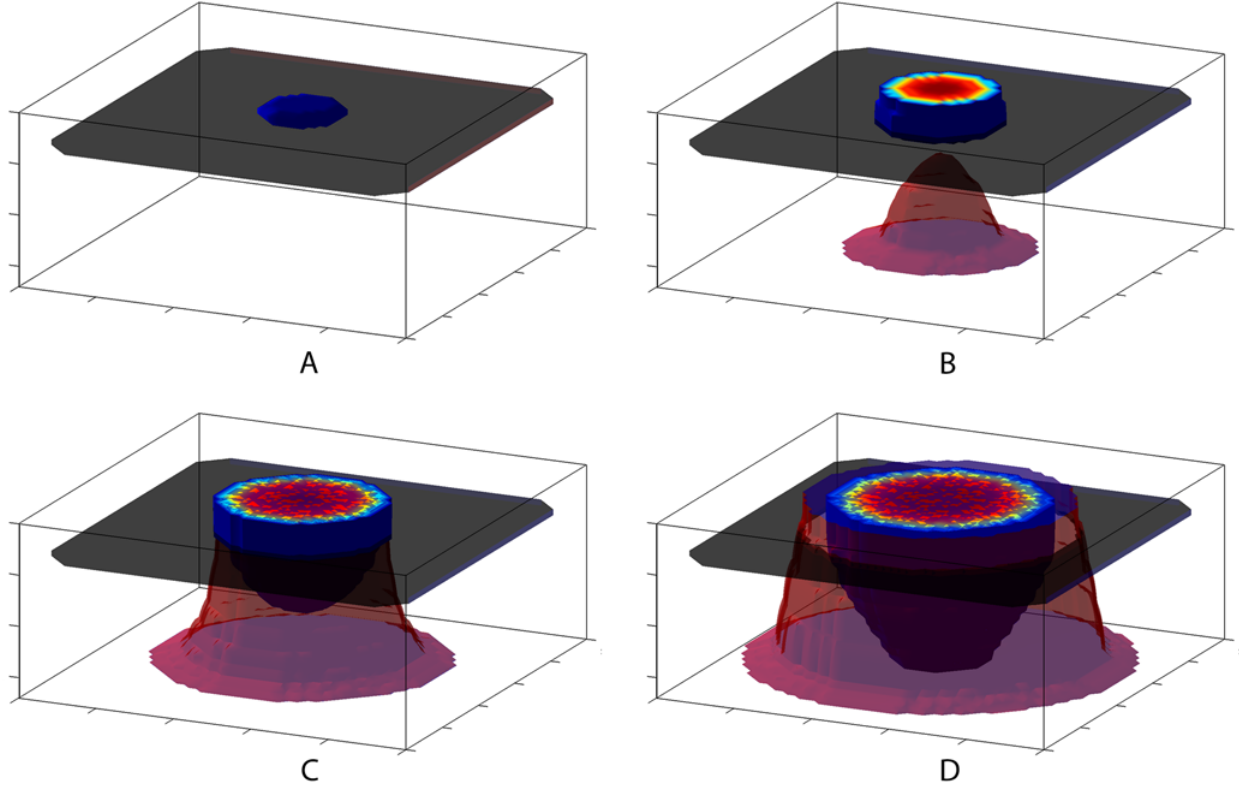
Figure 3. Isosurface of tumor cells (blue), the basement membrane (gray), and endothelial cells (red) for a course of invasion using the basic model. Time steps are evenly spaced over roughly 4.5 months of invasion. (A) An small initial tumor seed in the epidermis. (B) The tumor has spread radially within the epidermis, and endothelial cells have begun migrating toward the tumor. (C) The basement membrane has been penetrated by the endothelial cells, and the cancer cells have begun to invade vertically into the tumor vasculature. (D) A growing vasculature leads the advancing edge of radial invasion. The tumor mass has penetrated to the base of the domain and the vascular bed.